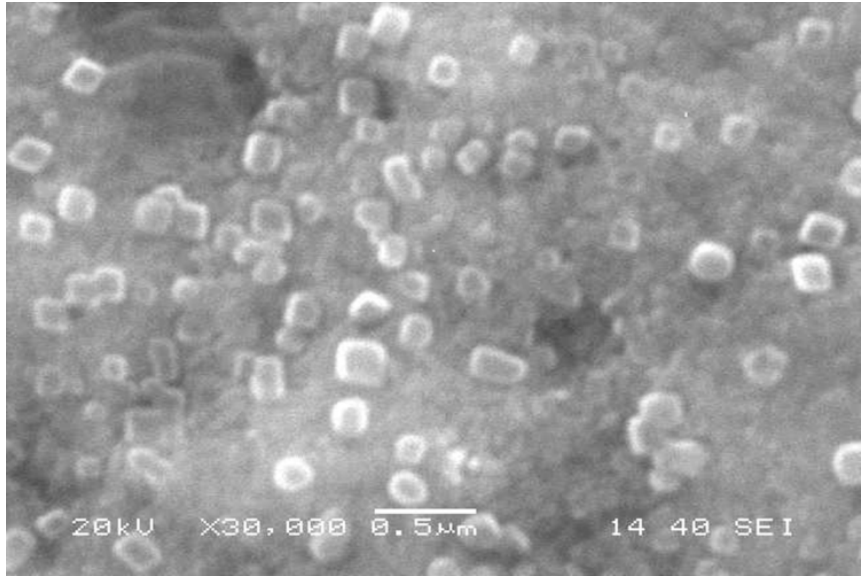
Figure 3. FTIR spectrum of biosynthesized Ag nanoparticles.